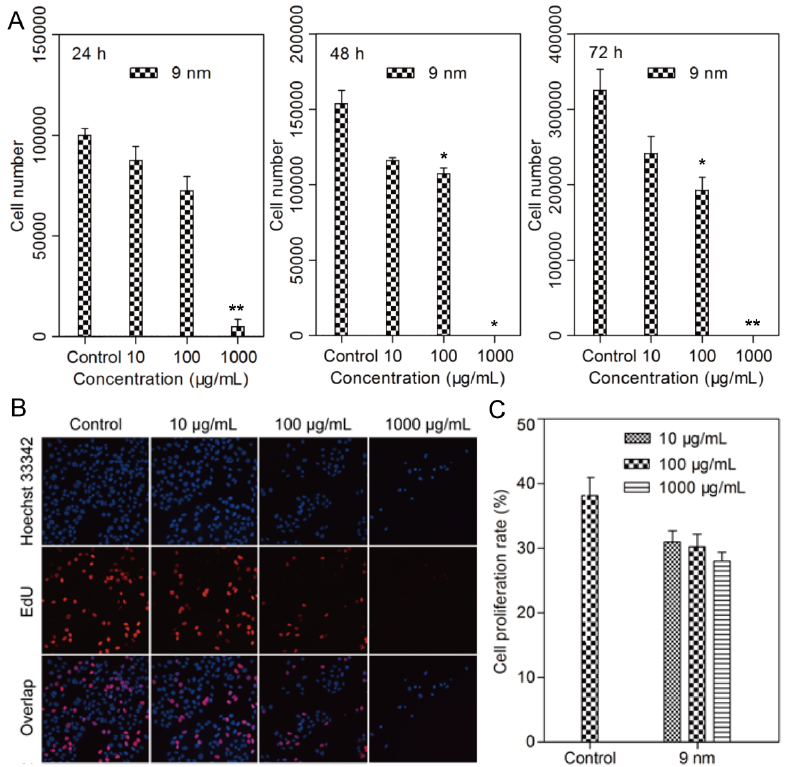
Figure 3: The influence of nanoparticles on cell proliferation: (A) Cell growth number of Fe 3 O 4 NPs-treated MCF-7 cells. (B) The proliferation image of MCF-7 cells treated with Fe 3 O 4 NPs for 48h. Blue fluorescence is from Hoechst 33342 nuclear staining. Red fluorescence is from Apollo DNA staining labelled by EdU. (C) Data quantitative image of cell proliferation. Data are presented as mean ± S.D.